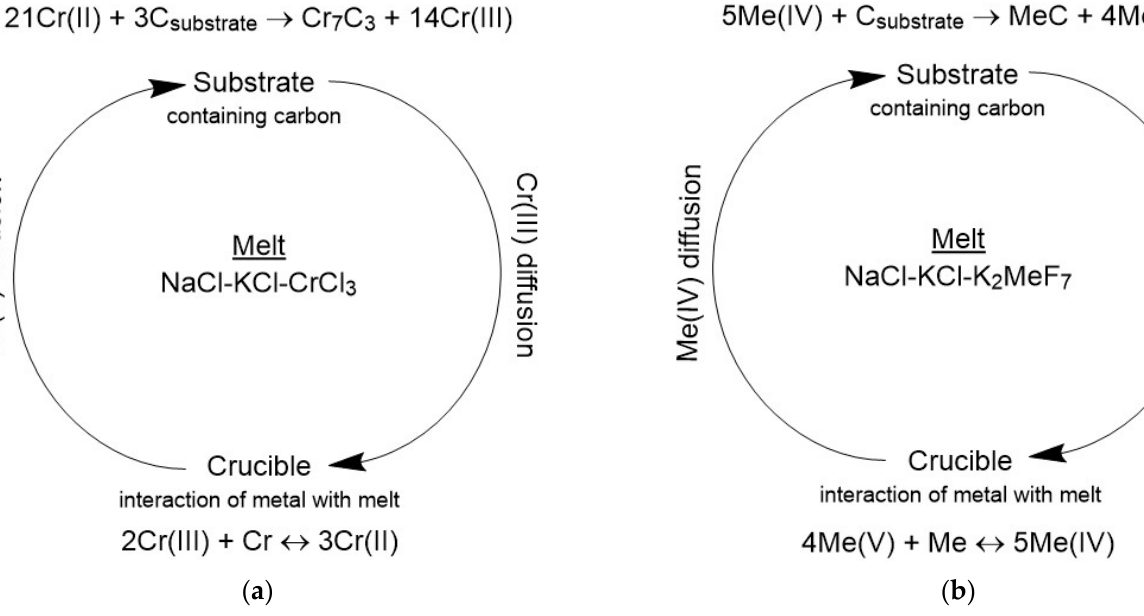
Figure 4. Principle scheme of coating synthesis by the CT in molten salts. ( a )—Cr 7 C 3 chromium carbide; ( b )—MeC carbides (Me = Nb, Ta).